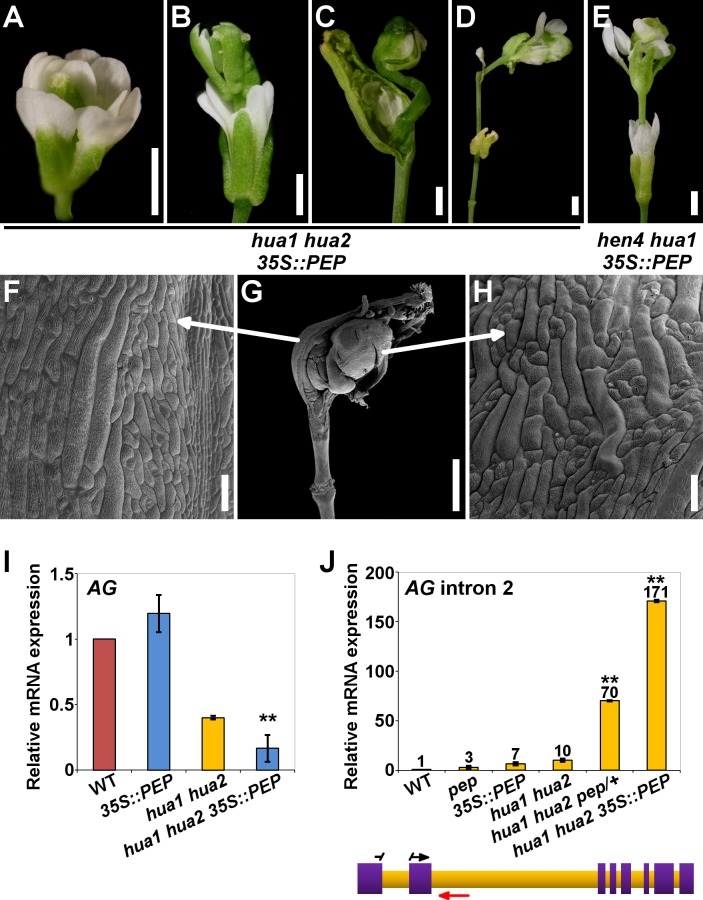

PEP overexpression impairs flower morphogenesis and AG pre-mRNA processing.A-D) hua1 hua2 35S::PEP flowers. E) hen4 hua1 35S::PEP flower. In both genotypes, loss of determinacy was frequent. All flowers displayed severely transformed petaloid stamens and sepaloid carpels. F-H) SEM micrograph of a hua1 hua2 35S::PEP flower (G), and close-up views of the fourth whorl organ abaxial surface (F) and inner additional whorl organ (H), respectively. Sepaloid traits were found in these gynoecia. I, J) Relative expression levels of AG mRNA (I) and AG transcripts including intron 2 sequences (J), in wild-type plants (WT) and diverse hua-pep mutant backgrounds, monitored by qPCR. In (J), a diagram of the AG gene is shown below. Purple boxes denote exons whereas intronic regions are colored in orange. Relative positions of forward (black arrow) and reverse (red arrow) primers are indicated. To increase annealing specificity, the forward primer sequence was split between exons 1 and 2. Error bars, SD. Asterisks indicate statistically significant differences from hua1 hua2 plants (**P < 0.01). Scale bars are 1 mm (A-E, G) and 100 μm (F, H).